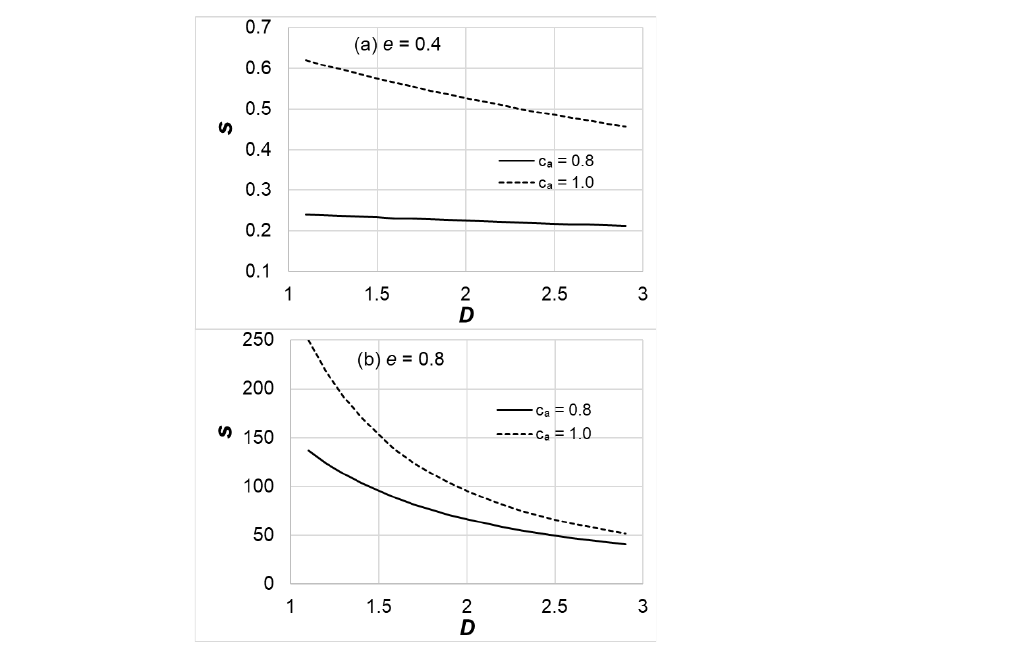
Figure 6. The influence of the fractal dimension D on the standard deviation of dimensionless permeability s for ( a ) e = 0.4 and ( b ) e = 0.8.